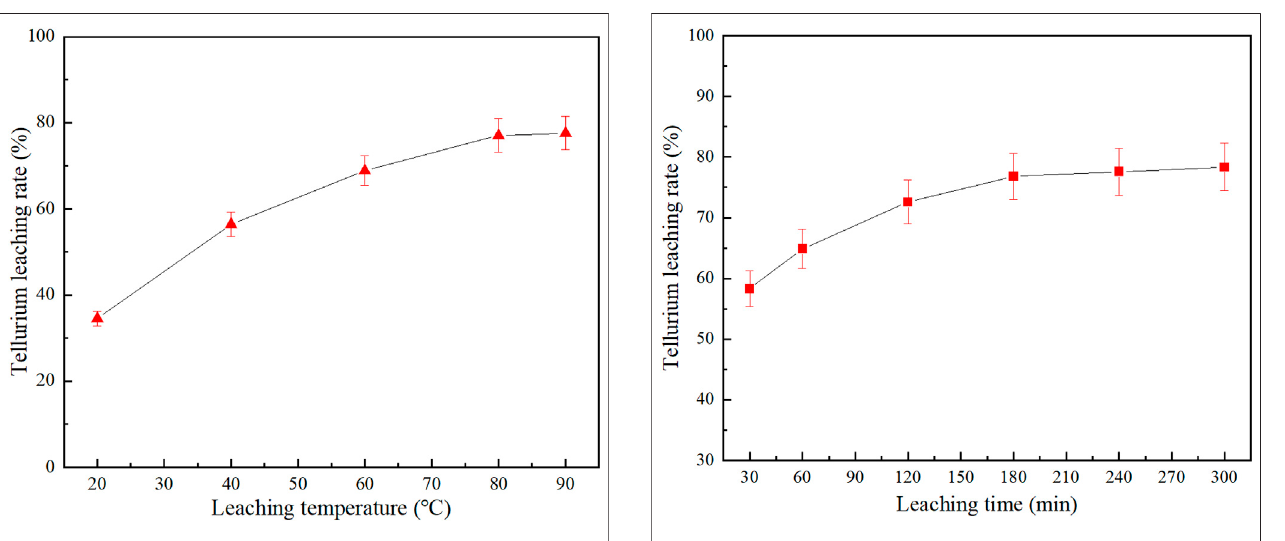
FIGURE 6 | Effect of leaching temperature on tellurium leaching rate. FIGURE 7 | Effect of leaching time on tellurium leaching